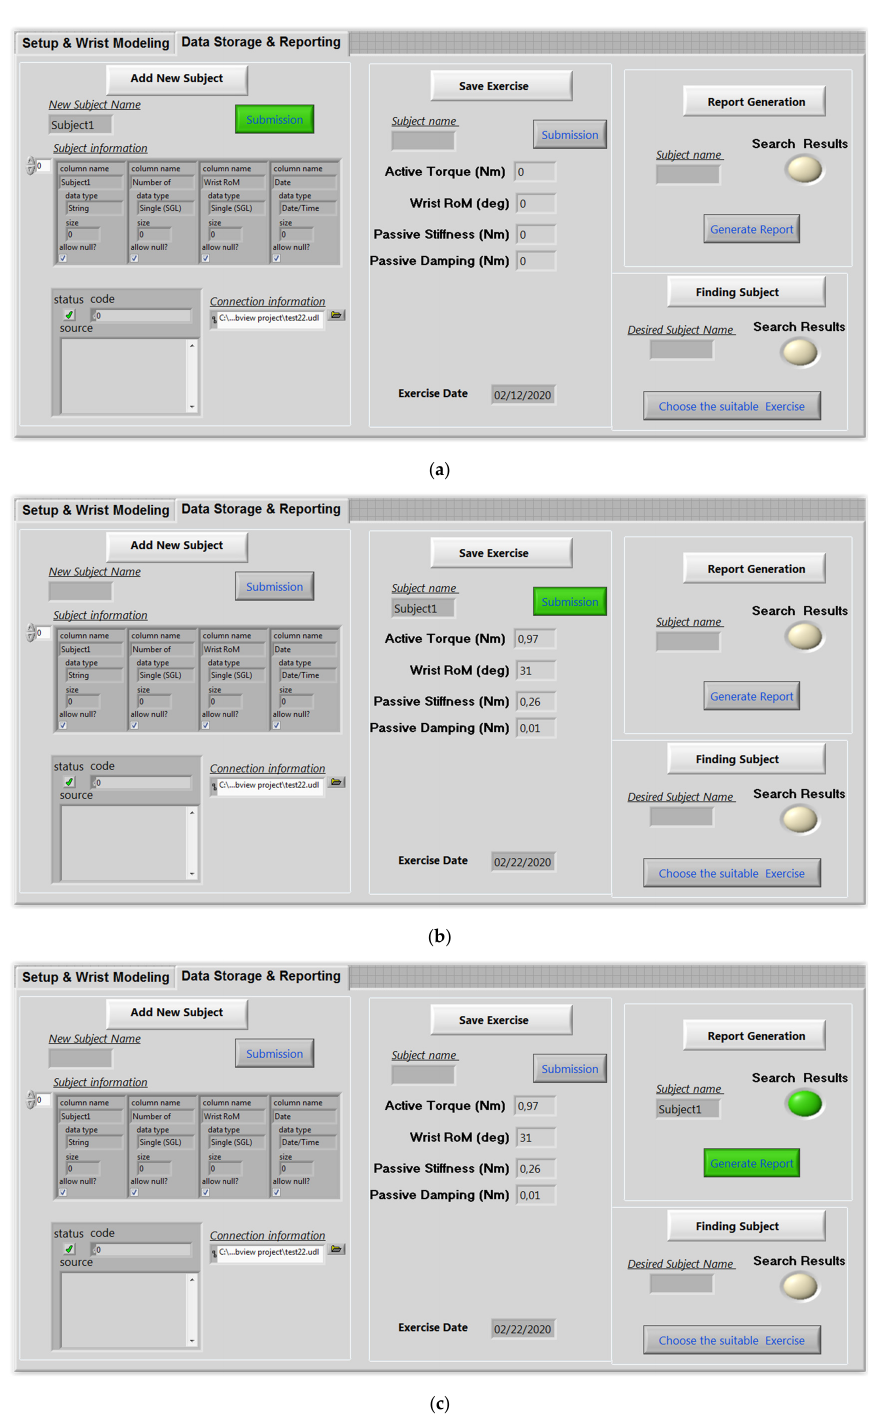
Figure 15. Data base interface: ( a ) Add new subject; ( b ) save exercise; ( c ) generate report.